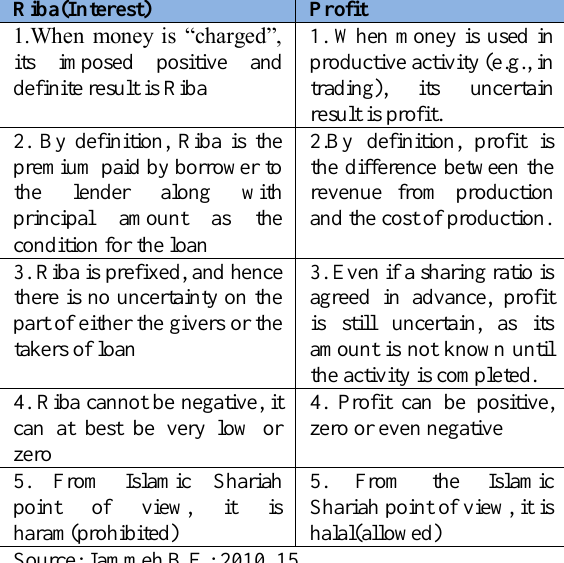
Table-1: Comparison between Riba (Interest) and Profit